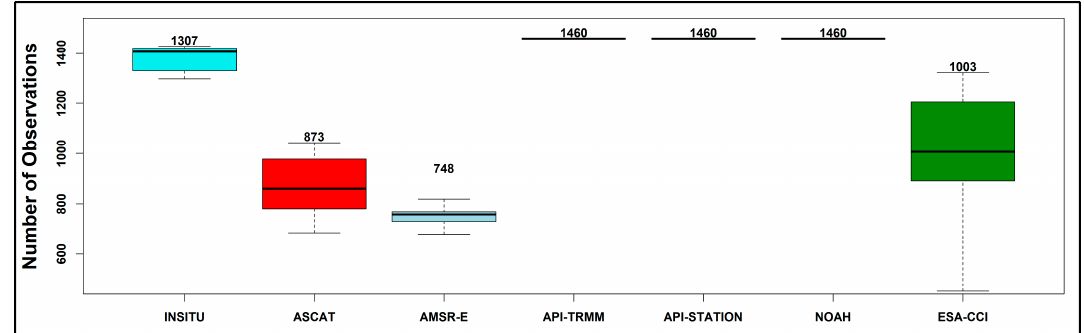
Figure 5. Temporal data availability of each soil moisture product in the study period (2008-2011)